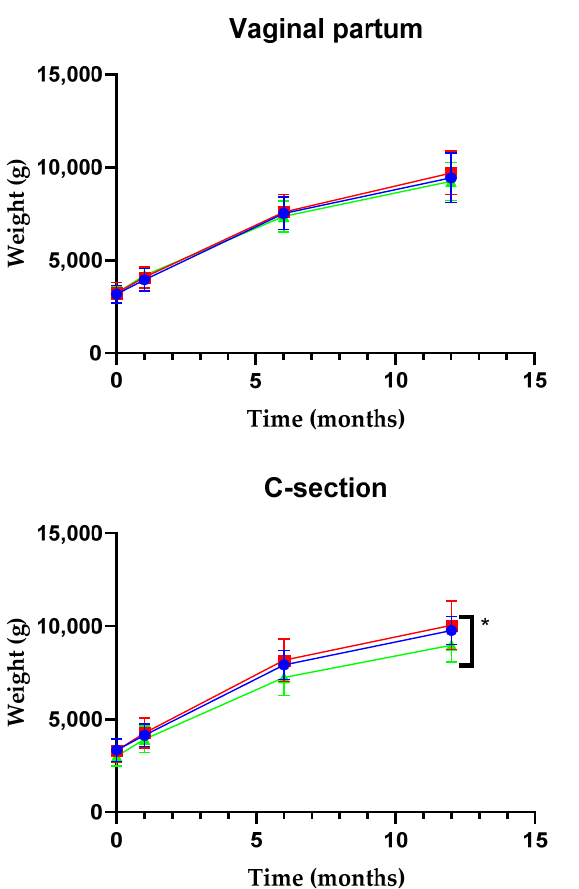
Figure 2. Long-term variations in body weight for the tertiles according to fecal levels of the Staphylococcus at 1 month of age in vaginally delivered or C-section-delivered babies ( n = 122) (T1, tertile 1; T2, tertile 2; T3, tertile 3). * p ≤ 0.05.